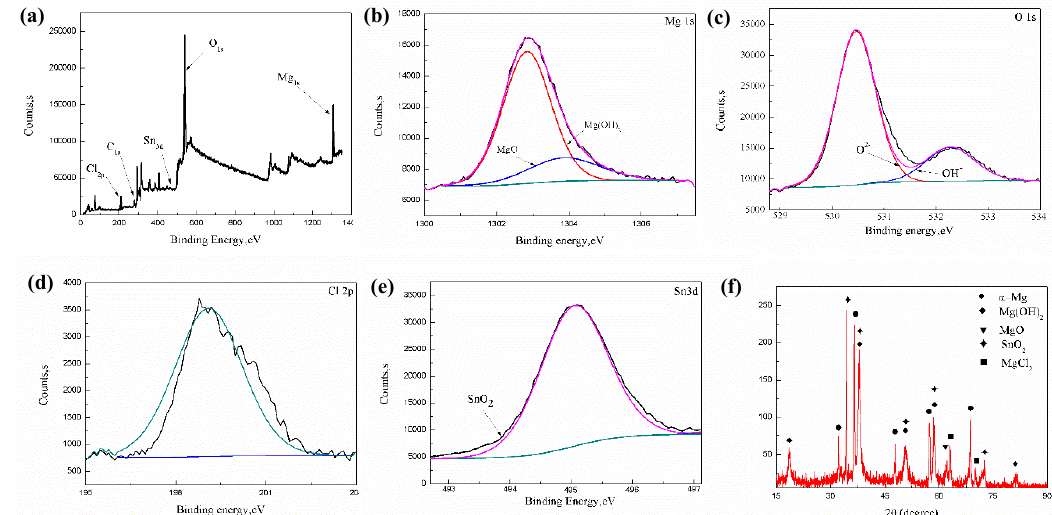
Figure 8. X-ray photo-electron spectroscopy (XPS) and X-ray diffraction (XRD) analysis formed oxide film on the extruded alloy surface: ( a ) survey scanning spectrum, ( b ) high-resolution Mg 1s spectrum, ( c ) high-resolution O 1s spectrum, ( d ) high-resolution Cl 2p spectrum, ( e ) high-resolution Sn 3d spectrum. ( f ) XRD pattern of corrosion products.